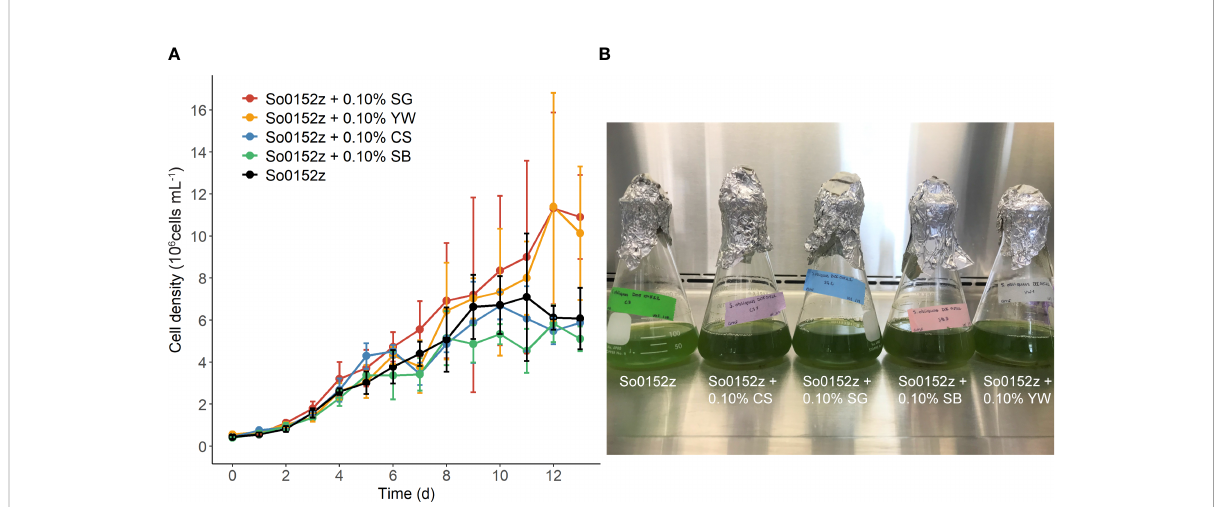
FIGURE 1 (A) Growth of S. obliquus in the presence of four different plant substrates compared to the microalga alone. Points and error bars indicate mean and standard deviation of three biological replicates. (B) Photo of one replicate from each treatment, from left to right: S. obliquus